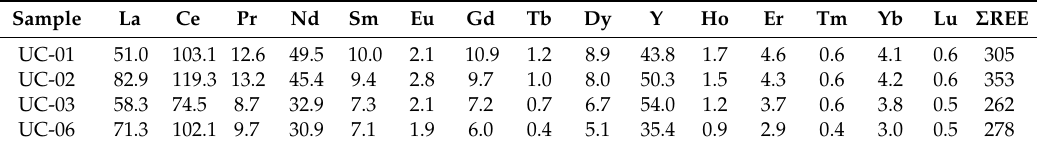
Table 5. Rare earth element concentrations (mg / kg) in West Virginia coal underclay samples. Values are reported on a whole sample basis.